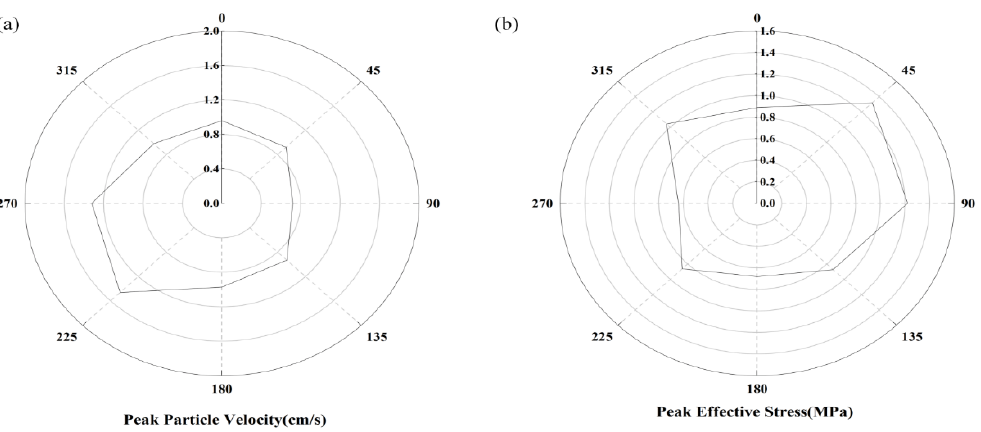
Figure 8. Pipeline cross-section dynamic response characteristics under this study’s construction conditions: ( a ) peak particle velocity; ( b ) peak effective stress.